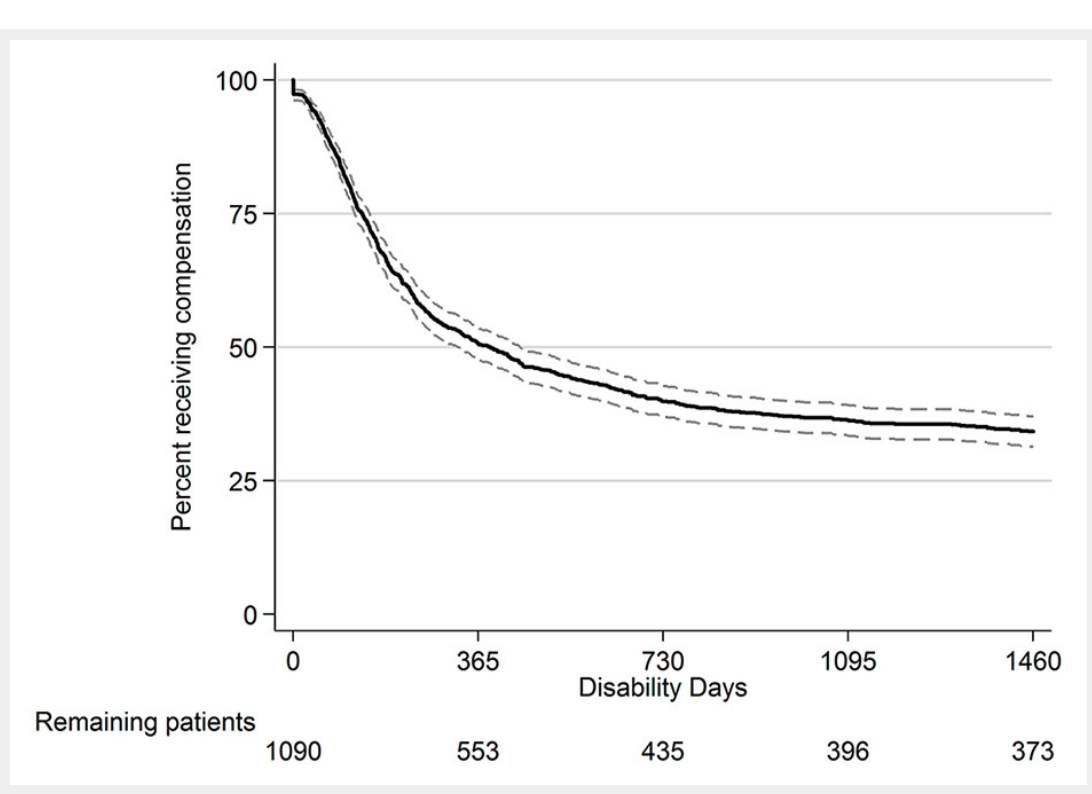
Figure 1 Kaplan-Meier survival function with 95% confidence